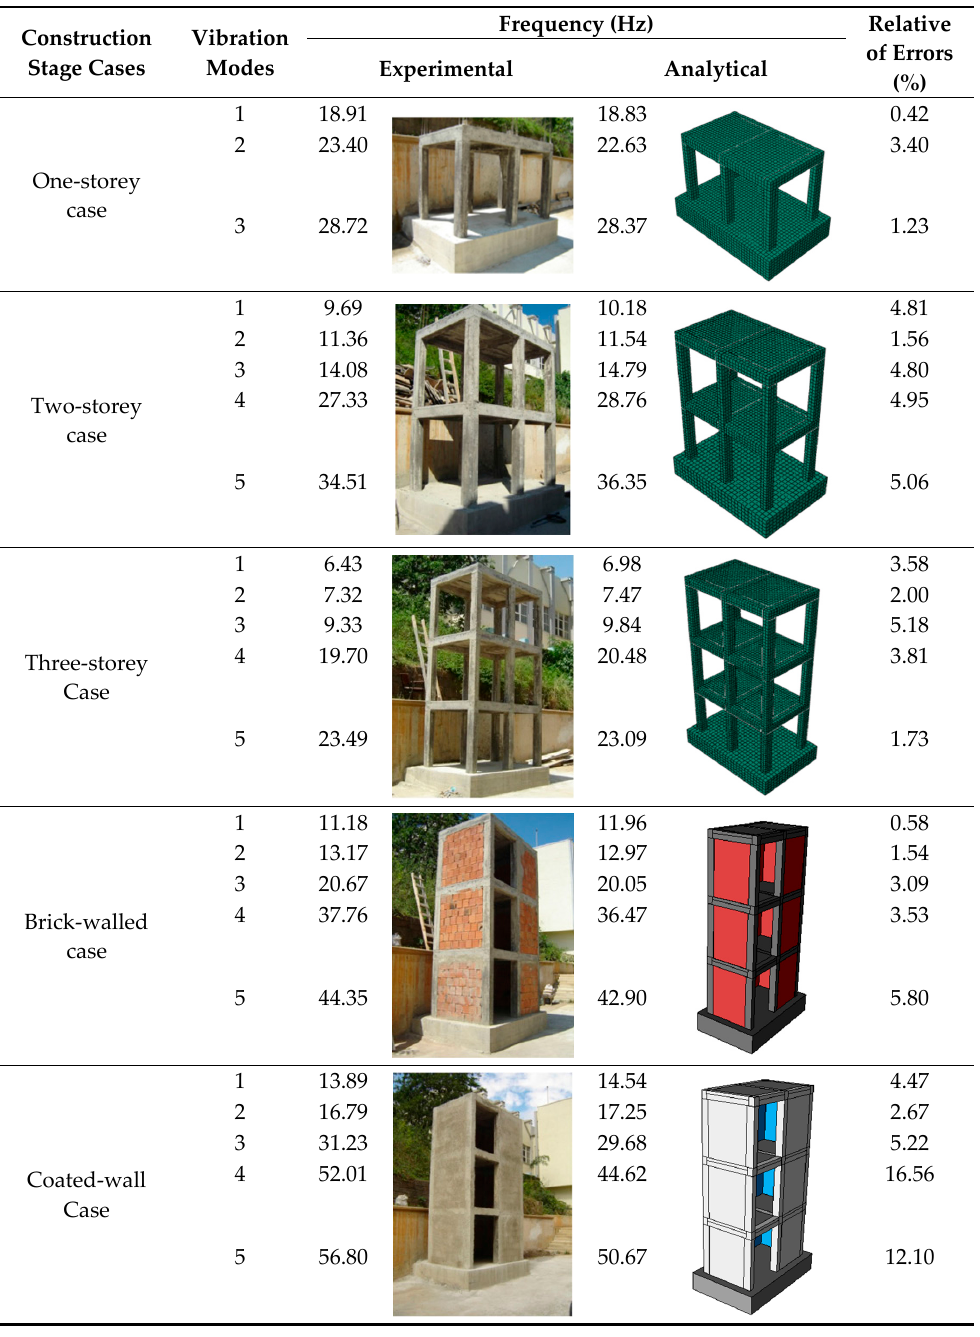
Table 3. Relative errors (%) between experimental and numerical frequencies.